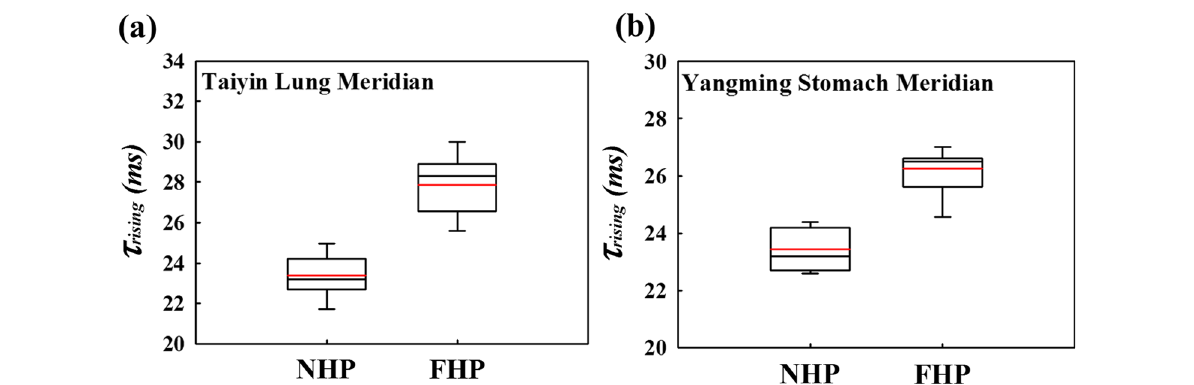
Fig. 8 Box plot of τ rising of the a Taiyin lung meridian and b Yangming stomach meridian. The red line in the box plot is the mean value of the data